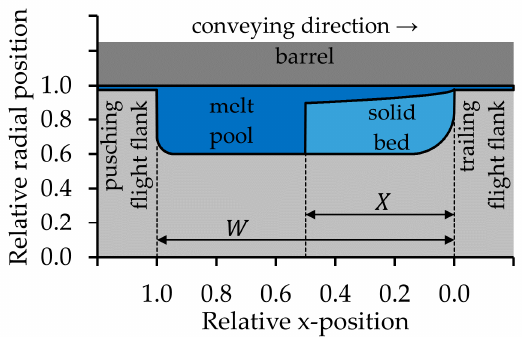
Figure 1. Simplified schematic drawing of the contiguous solids melting mechanism (CSM) in the flat screw channel, adopted and adapted from Gogos and Tadmor [6]. W is the channel width and X is the width of the solid bed. The melt film between the solid bed and both the screw root and the passive screw flight is not shown.